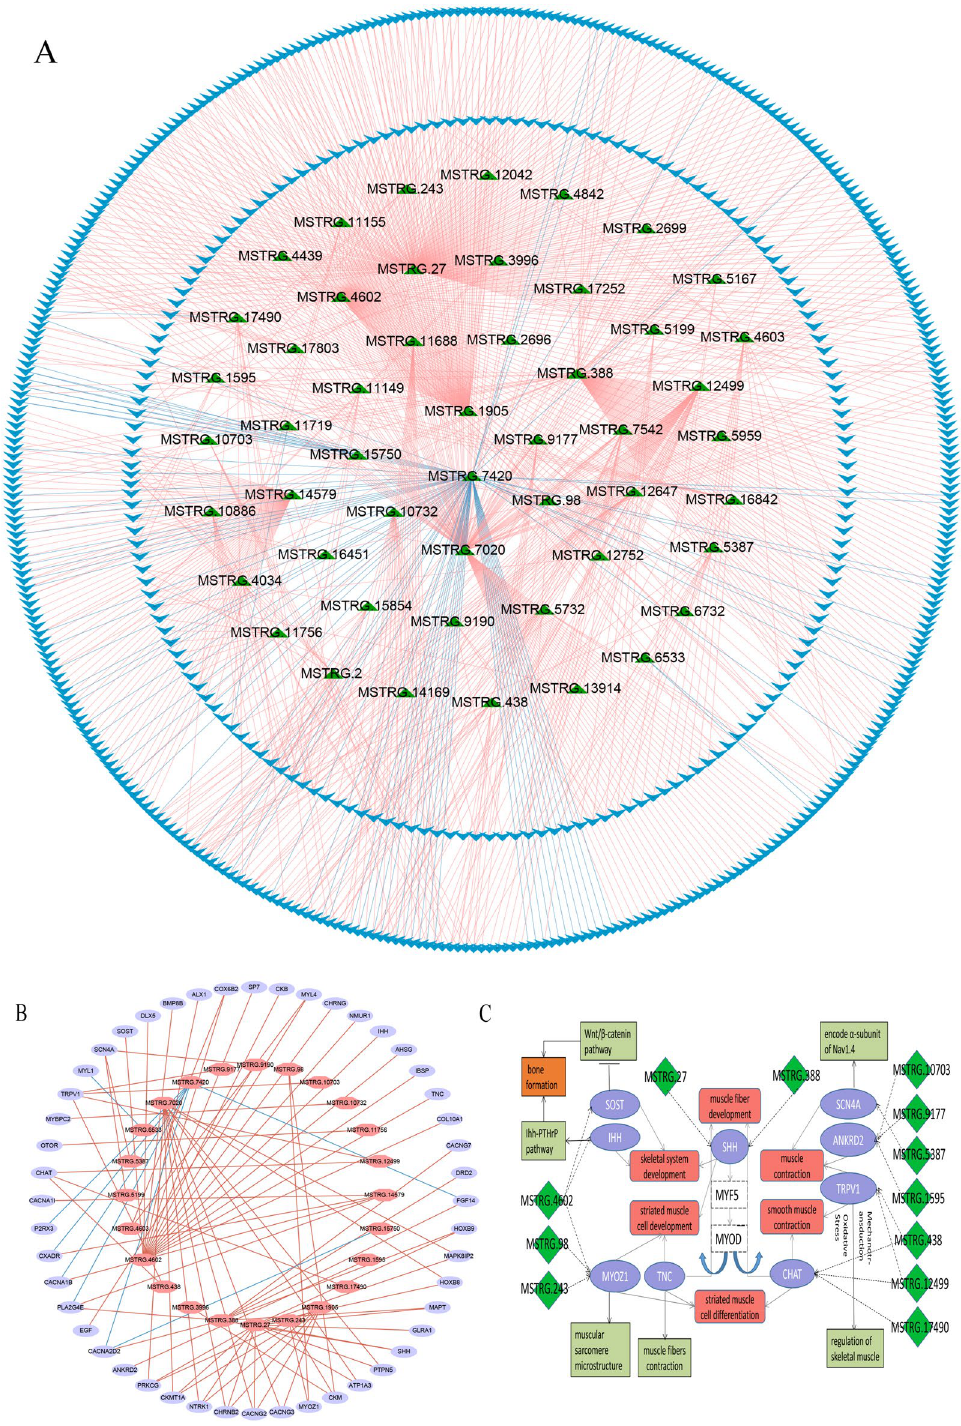
Figure 6. Correlation expression regulation analysis of DE lincRNA genes and their potential target genes. (A) Co-expression network diagram between DE lincRNA genes and DEPTGs; (B) Co-expression network diagram between DE lincRNA genes and DEPTGs enriched in skeletal muscle development related pathways; (C) The interaction of major DE lincRNA genes and DEPTGs enriched in muscle-related